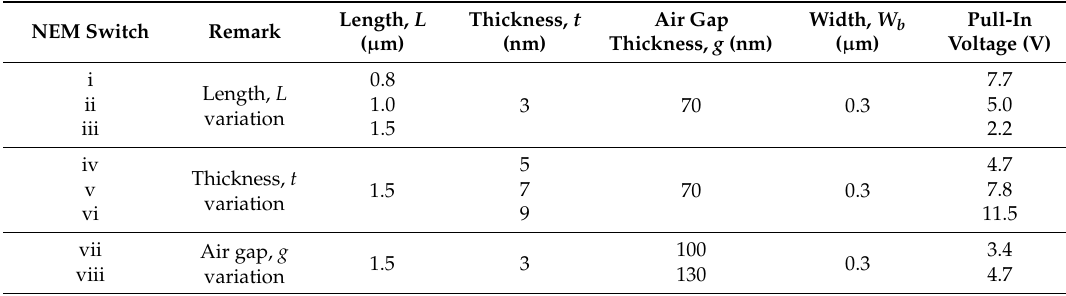
Table 2. Dimensions of intact graphene-based NEM switch with variation of beam length ( L ), thickness ( t ), and air gap thickness ( g ).